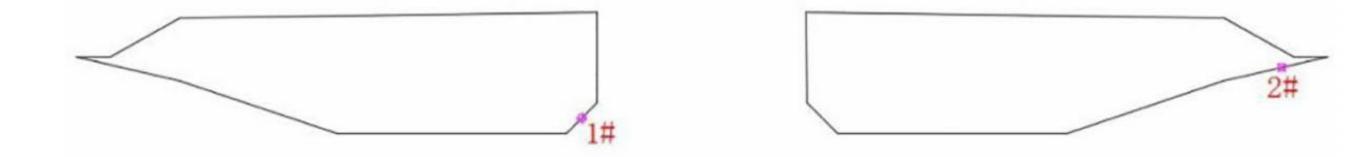
Figure 8. The layout of pressure measuring points in the wake